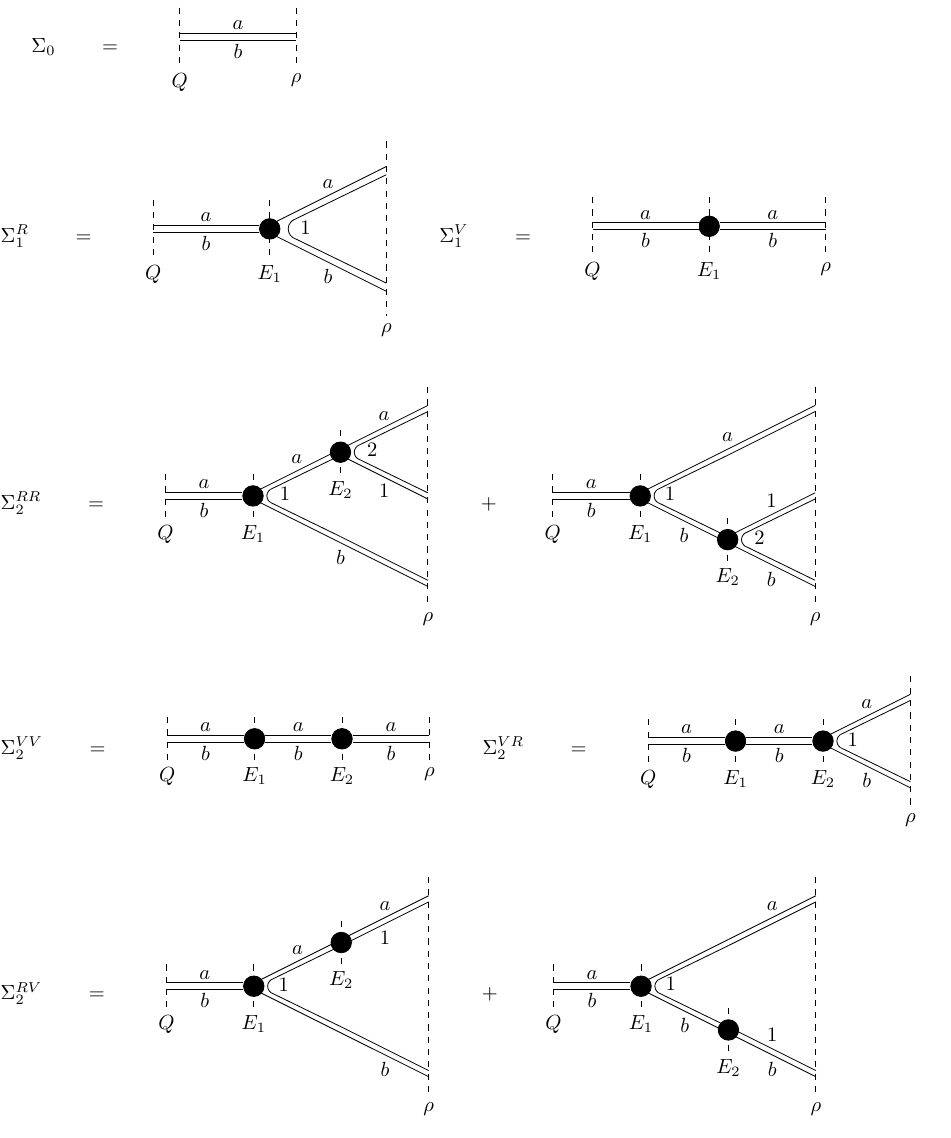
1 Figure 4 . The leading- N graphs corresponding to eq.